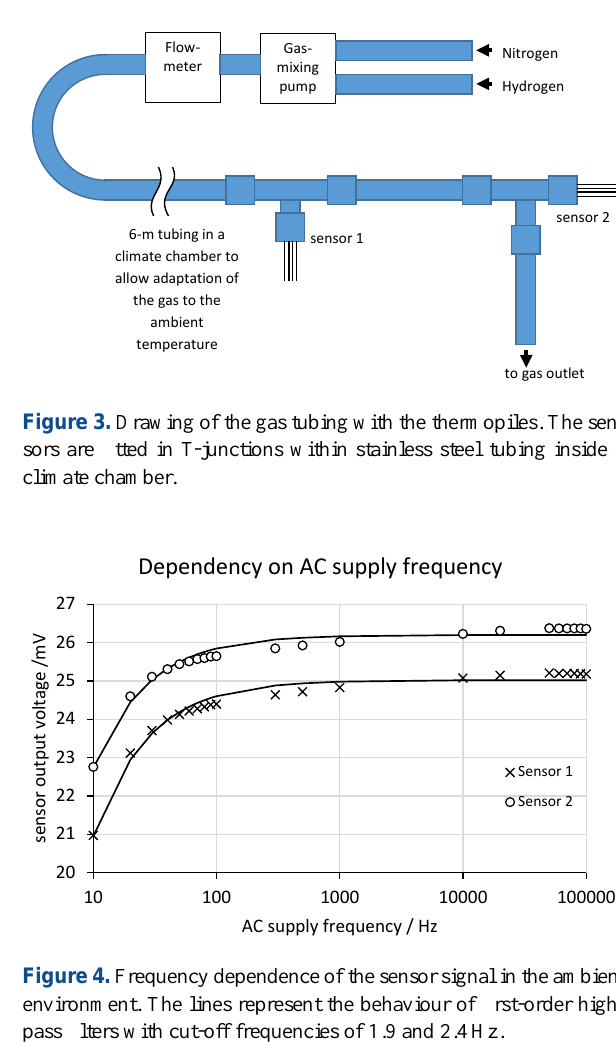
Figure 6. Measurements of the sensor 1 signal with different H 2 concentrations. The measurements were performed at 5 ◦ C in a climate-controlled room. If not indicated differently, all measure- ments were performed at flow rates of 0.5Lmin − 1